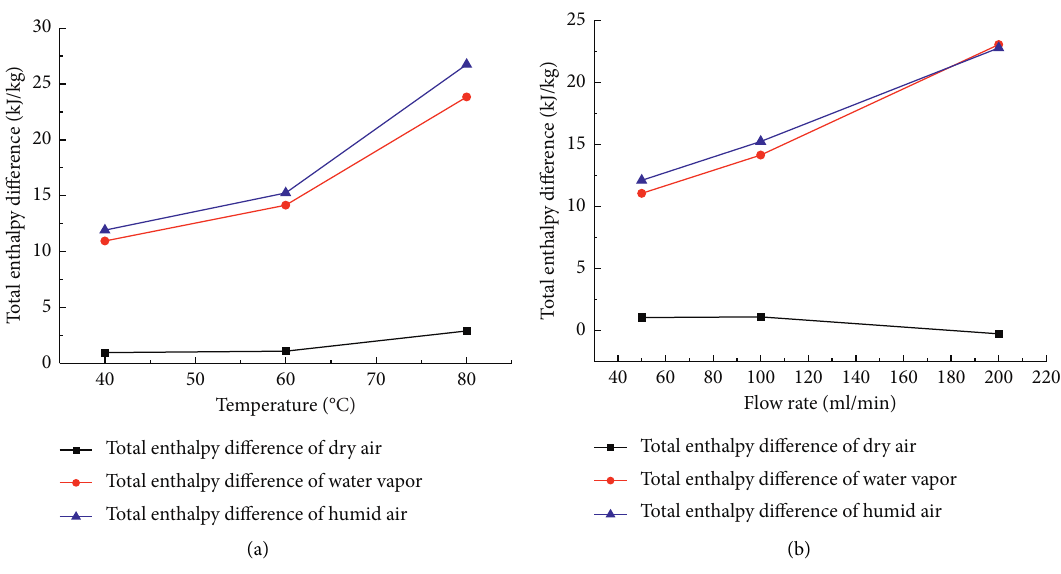
Figure 8: Total enthalpy difference variations of the trickling roadway. (a) Q � 100ml/min. (b) T � 60 °